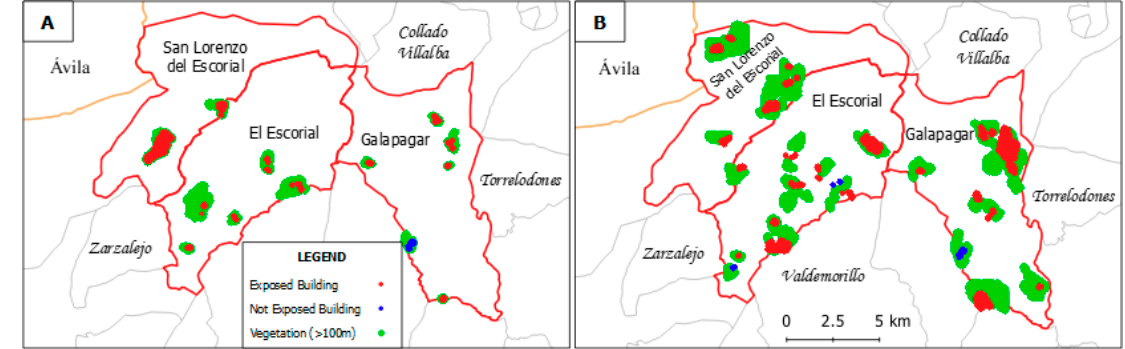
Figure 8. Clusters distribution in Garraf for analysis of intermix ( A ) and interface ( B ).